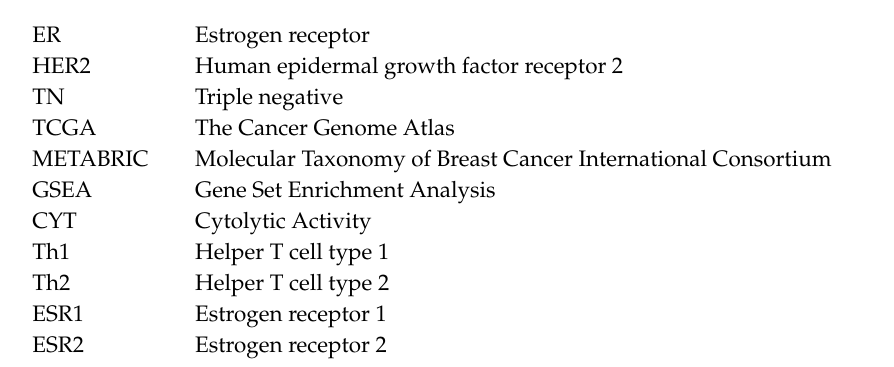
Figure S1: Downregulation of miR-143 in breast cancer cell lines when compared with normal epithelial cell line (a). Downregulation of miR-143 with tumor samples compared with normal tissue in clinical samples (b), Figure S2: Western blot analysis of PARP at 72 h after transfection with control RNA (40 nM) or syn-miR-143 (10 nM, 40 nM) to MB-231 cells (a). Hoechst 33342 staining of MB-231 cells at 96 h after transfection with control RNA (10 nM) or syn-miR-143 (10 nM) (b), Figure S3: The association between miR-143 expression and clinical stage and histological grades. The association between miR-143 expression and patient clinicopathological features between miR-143 high and miR-143 low group in whole groups and di ff erent subtypes. n.s., not statistically significant. ER + , estrogen receptor positive; HER2, human epidermal growth factor receptor 2; TN, triple negative, Figure S4: Infiltration of NK cells did not demonstrate the significant di ff erence between miR-143 high and low tumors with TCGA whole cohort. n.s., not statistically significant. NK cell, Natural killer cell, Figure S5: Assessing correlation between miR-143 and ESR1 or ESR2 with Pearson correlation analysis on TCGA